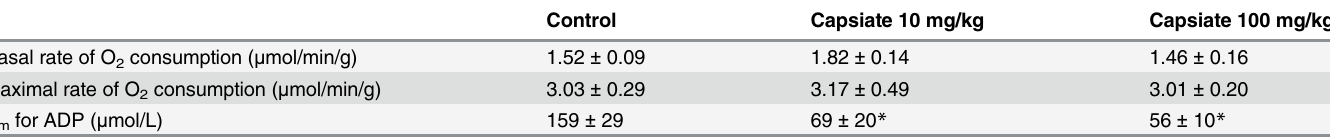
Values are means ± SEM. n = 6 per